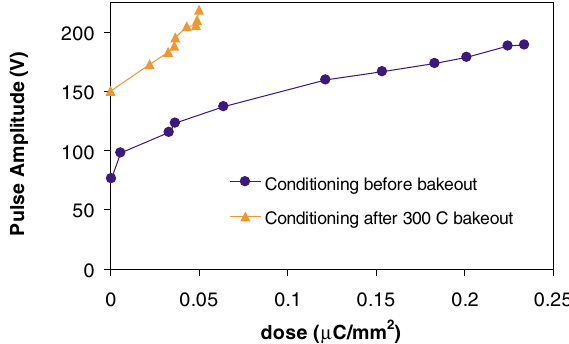
FIG. 3. (Color) Minimum pulse amplitude required to trigger multipacting as a function of electron dose for a stainless steel surface after bakeout (upper curve) and for unbaked stainless steel (lower curve). See Ref. [2] for more details.